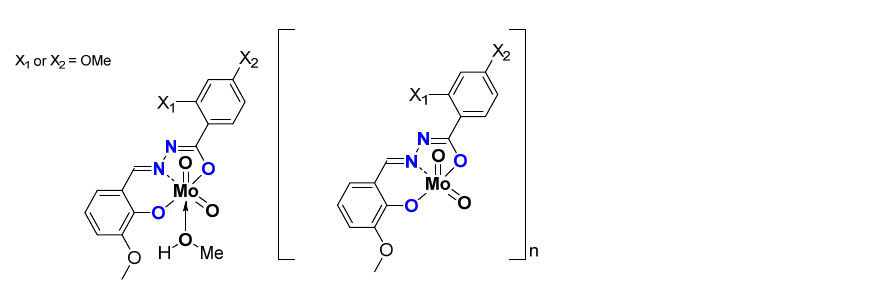
Figure 10. Schematic representation of neutral oligomeric and polymeric species studied containing the hydrazonato ligand. Table 7. Results of CO epoxidation and selectivity toward COE under organic solvent free condi- tions with MoO 2 L complexes of Figure 10.